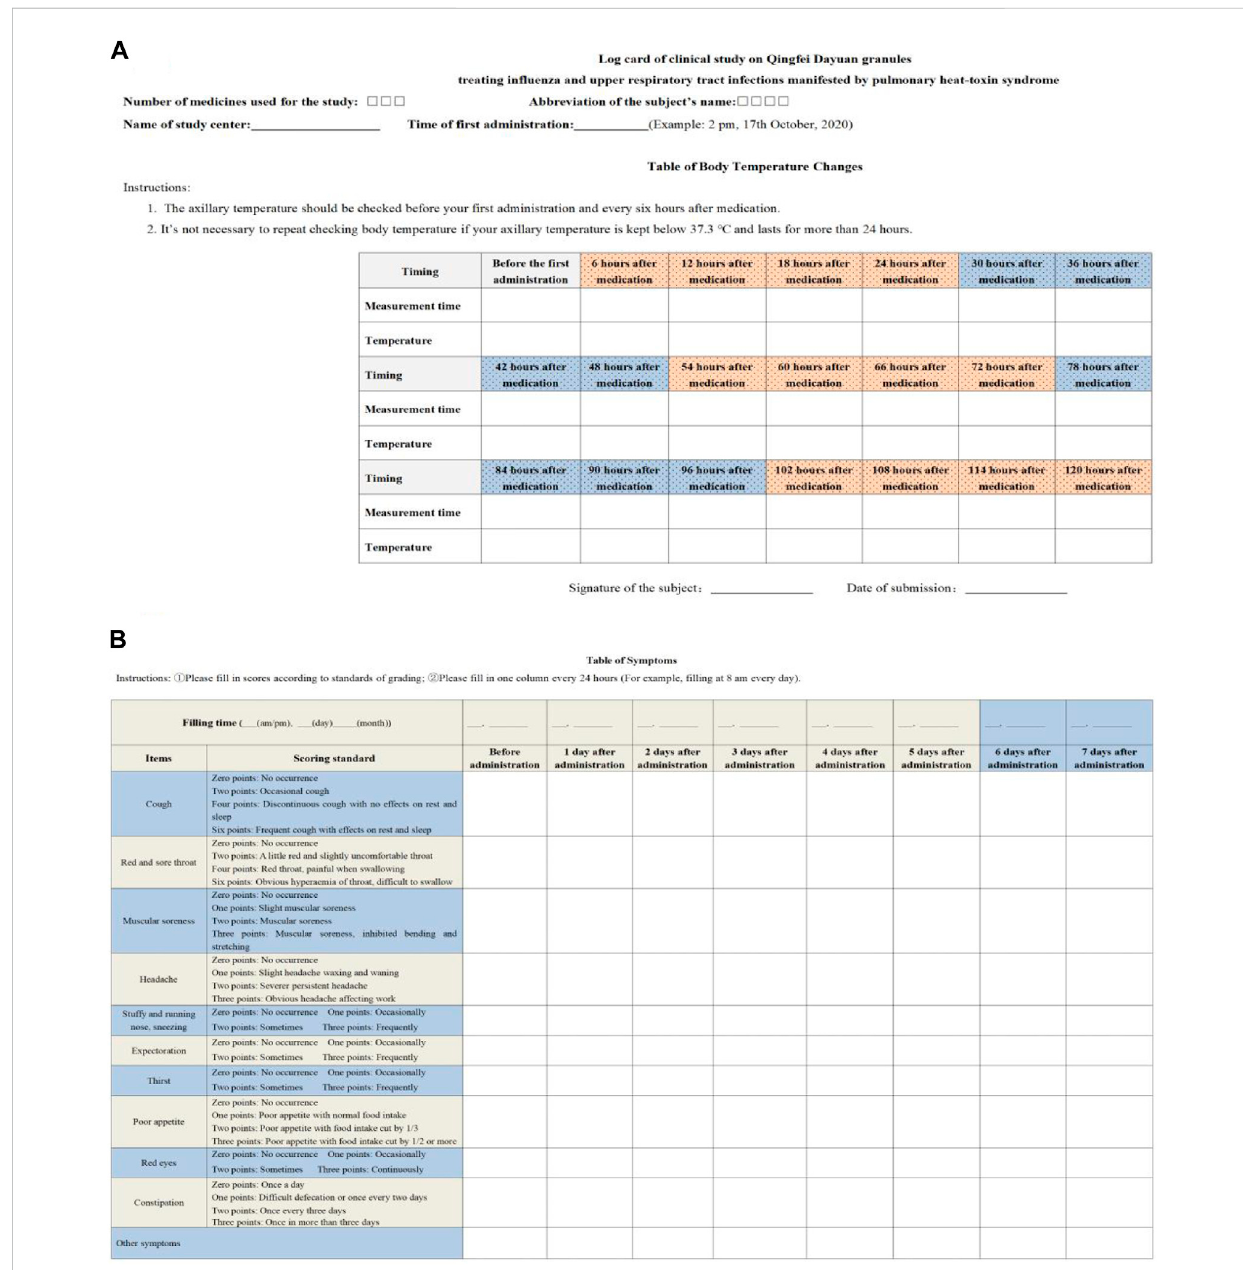
FIGURE 2 Log card of the clinical study. (A) is table of body temperature changes. (B) is table of